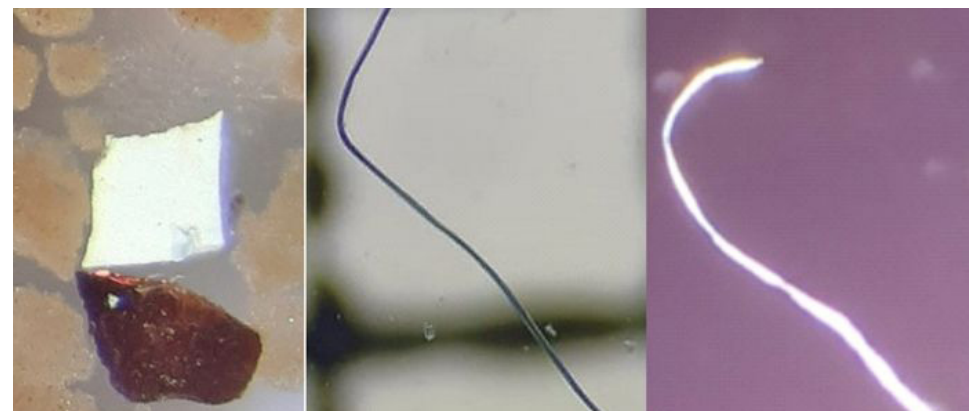
Figure 1. Study area, the location of the sampled sites can be observed.